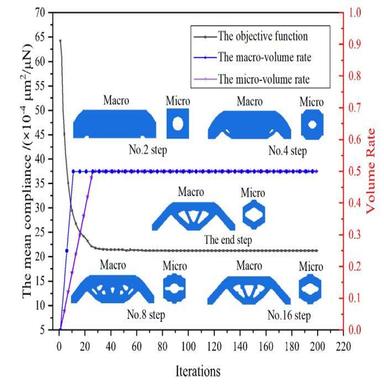
Optimization iteration history for the cantilever beam with different Lm.